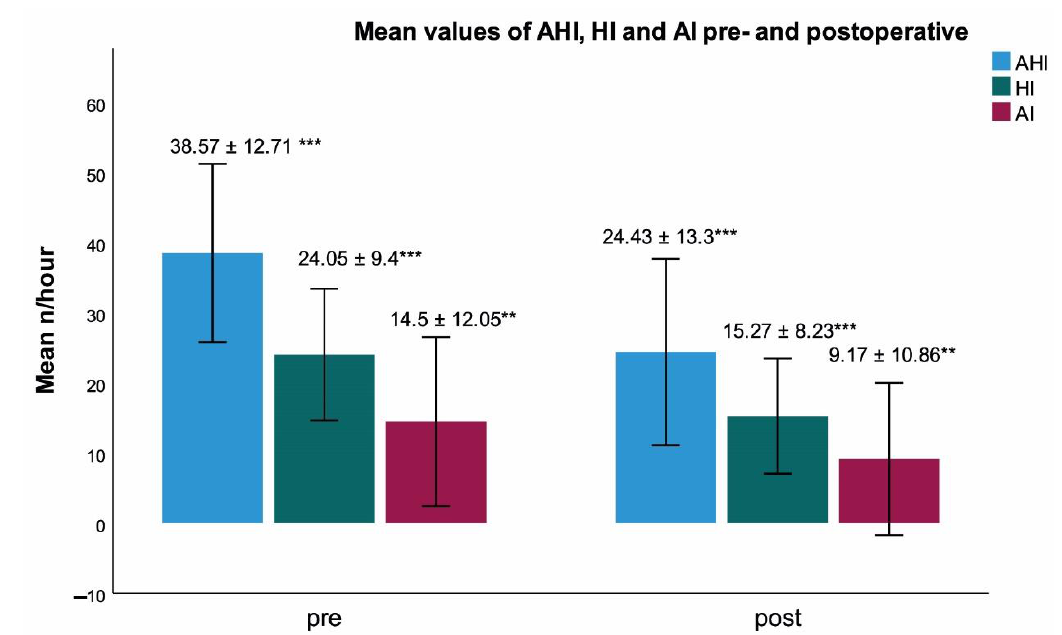
Figure 1. Comparison of AHI, HI and AI pre- and postoperative: AHI: 38.57 ± 12.71, 24.43 ± 13.3 p < 0.001, HI: 24.05 ± 9.4, 15.27 ± 8.23 p < 0.001, AI: 14.5 ± 12.05, 9.17 ± 10.86, p < 0.01, ** = statistically significant difference with p < 0.01; error bar with ± 1SD, *** = statistically significant difference with p < 0.001; error bar with ± 1SD.